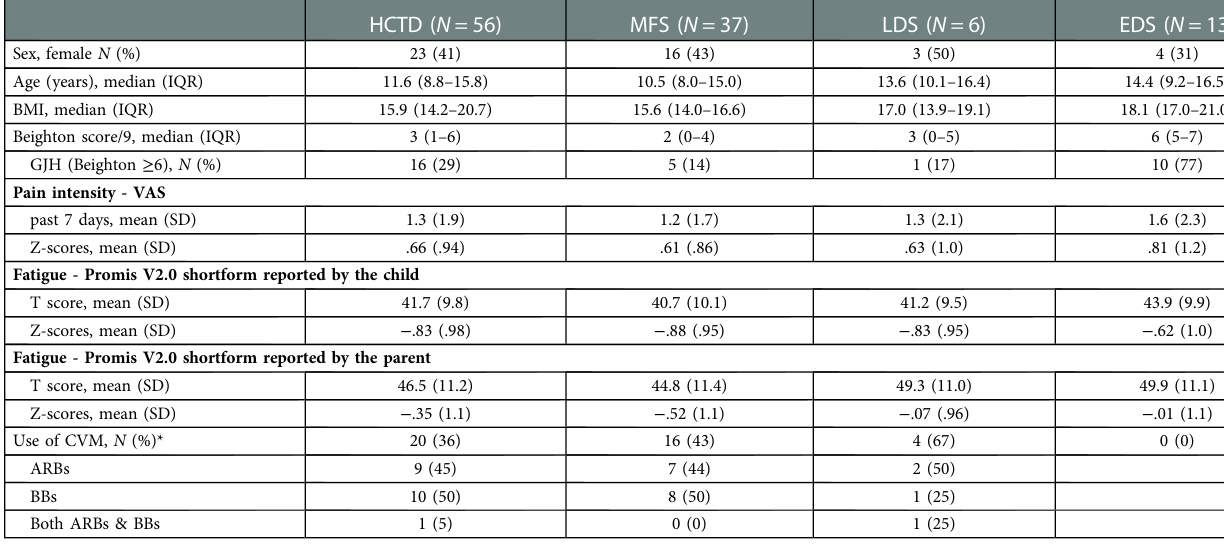
TABLE 1 Patient